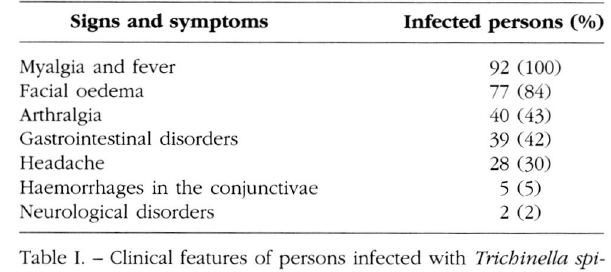
Table I. - Clinical features of persons infected with Trichinella spi ralis.